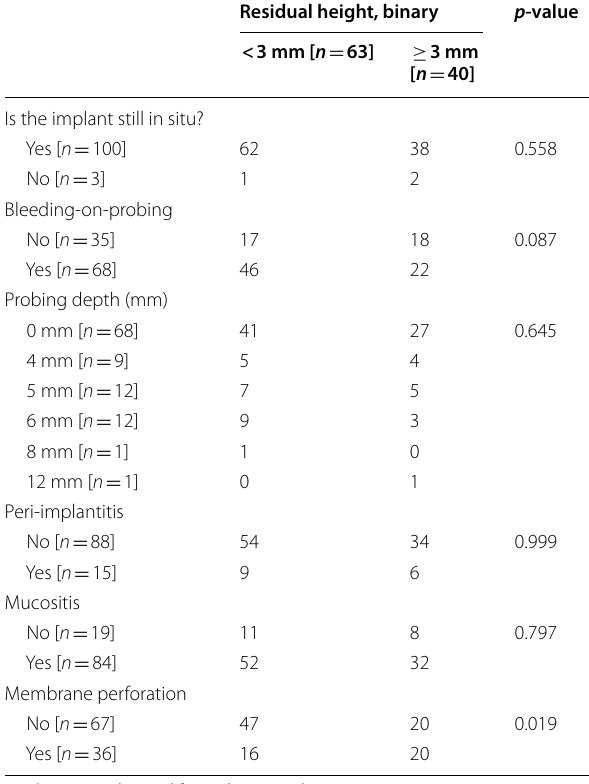
Table 2 Complications in dependence of the residual height of the alveolar